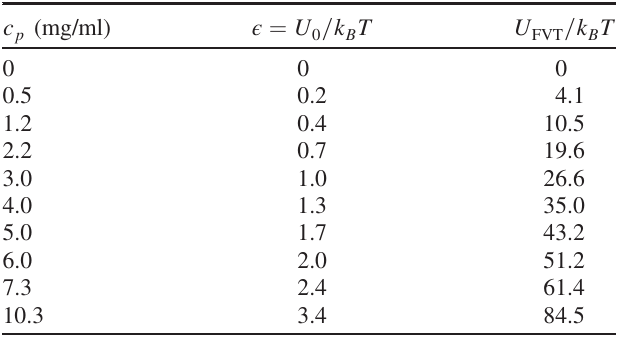
TABLE I. Polymer concentration ( c ) and corresponding p T ) estimated from the equa- attractive potential strength ( U 0 =k B T ¼ c =c 2 , where c 2 is the fitting parameter tion, ϵ ¼ U 0 =k B p =k T from the free- obtained from the graph in Fig. 4(e) and U B FVT volume theory (FVT) model